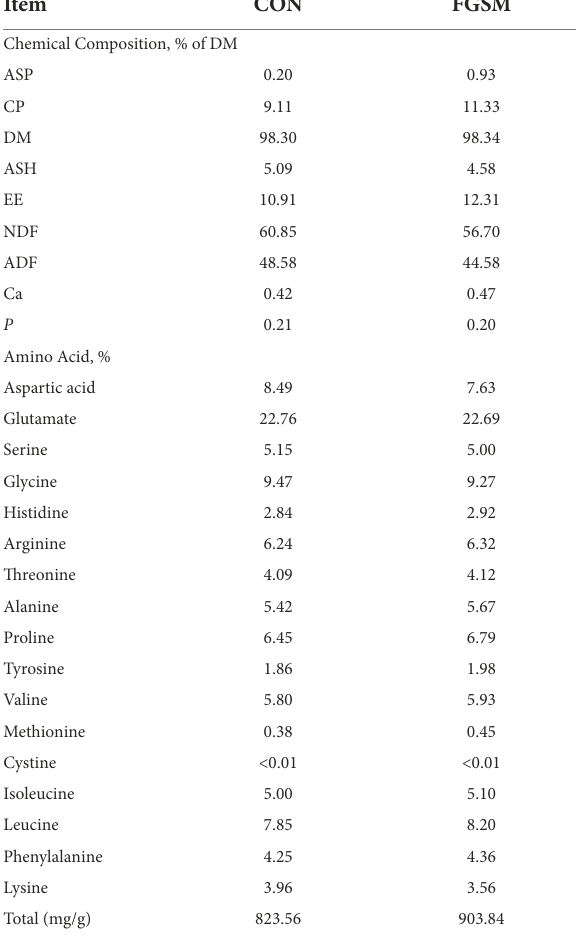
TABLE 2 Chemical composition and amino acid profile of FGSM and